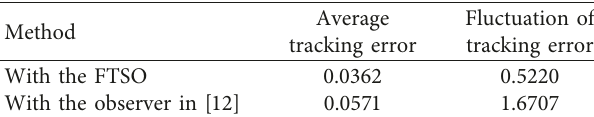
Table 1: Position tracking performance evaluation.